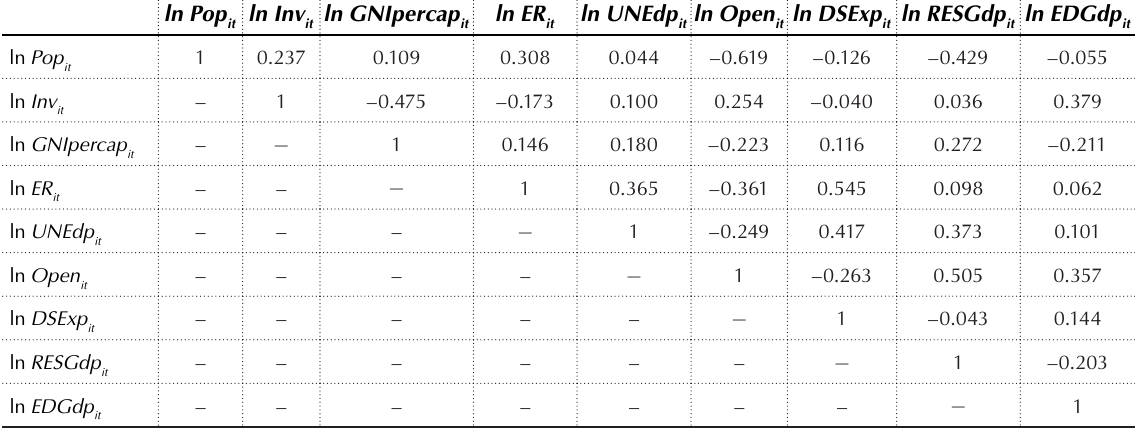
ln Pop ln Inv ln GNIpercap it it